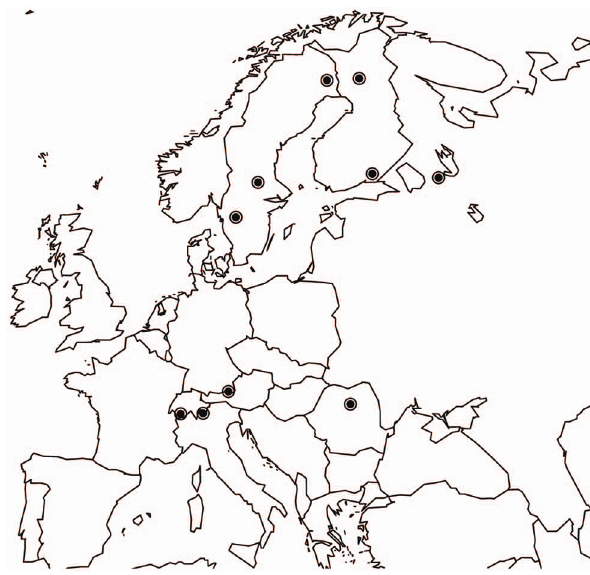
Figure 1. Map of Europe with sample locations shown as dots.